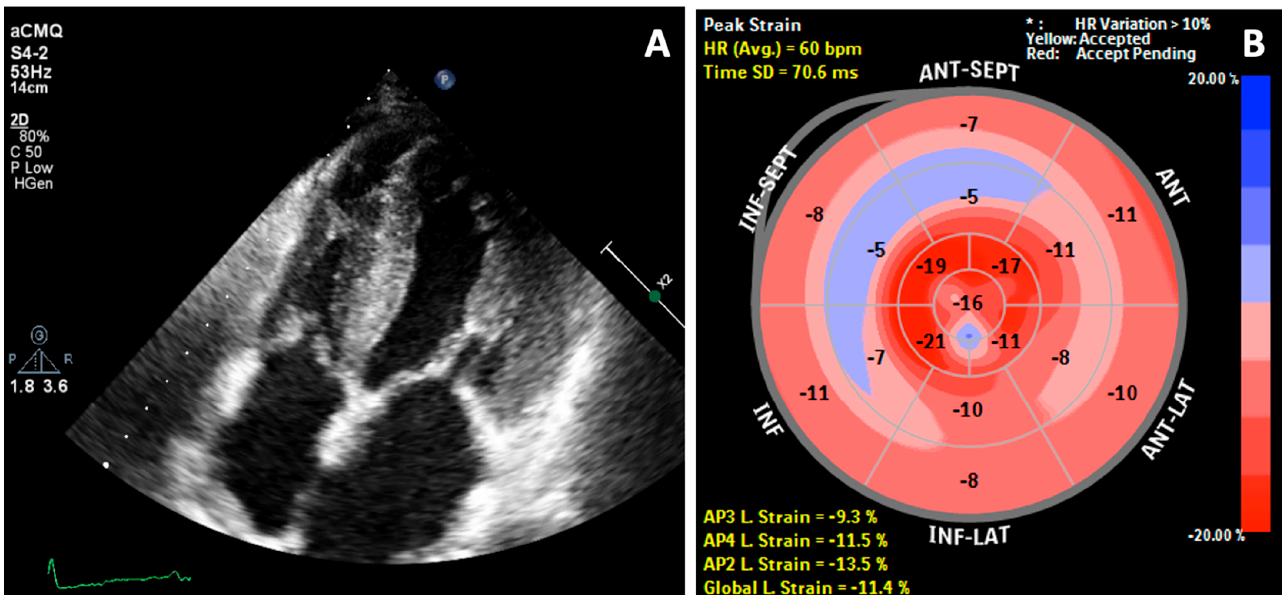
Figure 2. 2D Transthoracic echocardiography: ( A ) Thickening of both atria, right ventricle walls, atrial septum, valves, and papillary muscles and ( B ) Reduced global longitudinal strain (GLS = − 11.4%) with bull’s eye plot and pathognomonic pattern of relative apical sparing.